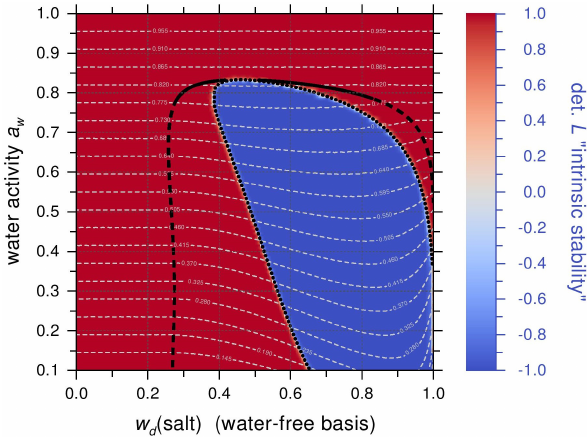
Figure 4. Predicted equilibrium phase diagram of the aqueous 3- MGA/AS system as a function of RH (or water activity, a w = RH / 100%) and mass fraction of AS in the dry 3-MGA/AS mixture, w d (salt). Predictions by AIOMFAC-LLE for T = 293K with crys- tallization of AS suppressed. Bold black solid and dashed curves: the binodal limit of single-phase stability, indicating a single liq- uid phase to be stable “outside” of it (at higher a w or low salt content). The dashed branches of the binodal curve indicate that dissolved AS in solution would be supersaturated relative to crys- talline AS at those compositions. Dotted curve: spinodal limit of stability, with a single liquid phase being intrinsically unstable in- side the area bounded by it (blue area). Red area: the composition space where a single liquid phase is stable or metastable with re- gard to LLPS (color scale has arbitrary units). Thin, grey dashed lines: equilibrium water activity contours (tie lines within LLE re- gion). An OIR = 1 corresponds to w d (salt) = 0.5, which leads to a near-immediate crossing of the spinodal limit when such a mixture is dried from high water activity (while w d (salt) = 0.5 remains con-